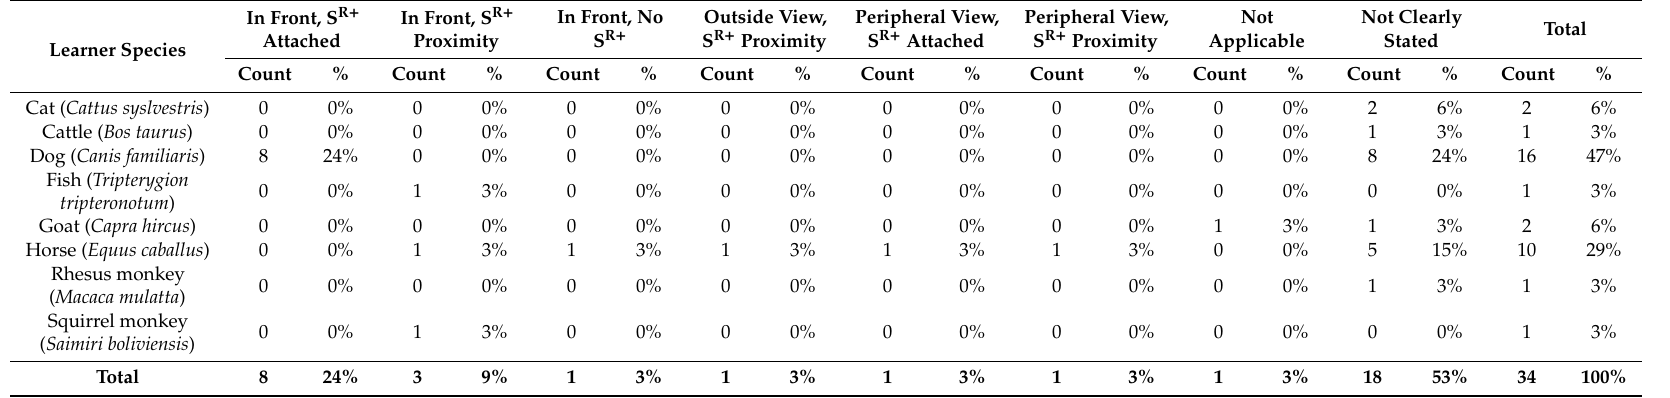
Table 8. Positioning of experimenters and trainers with respective reinforcers displayed by learner